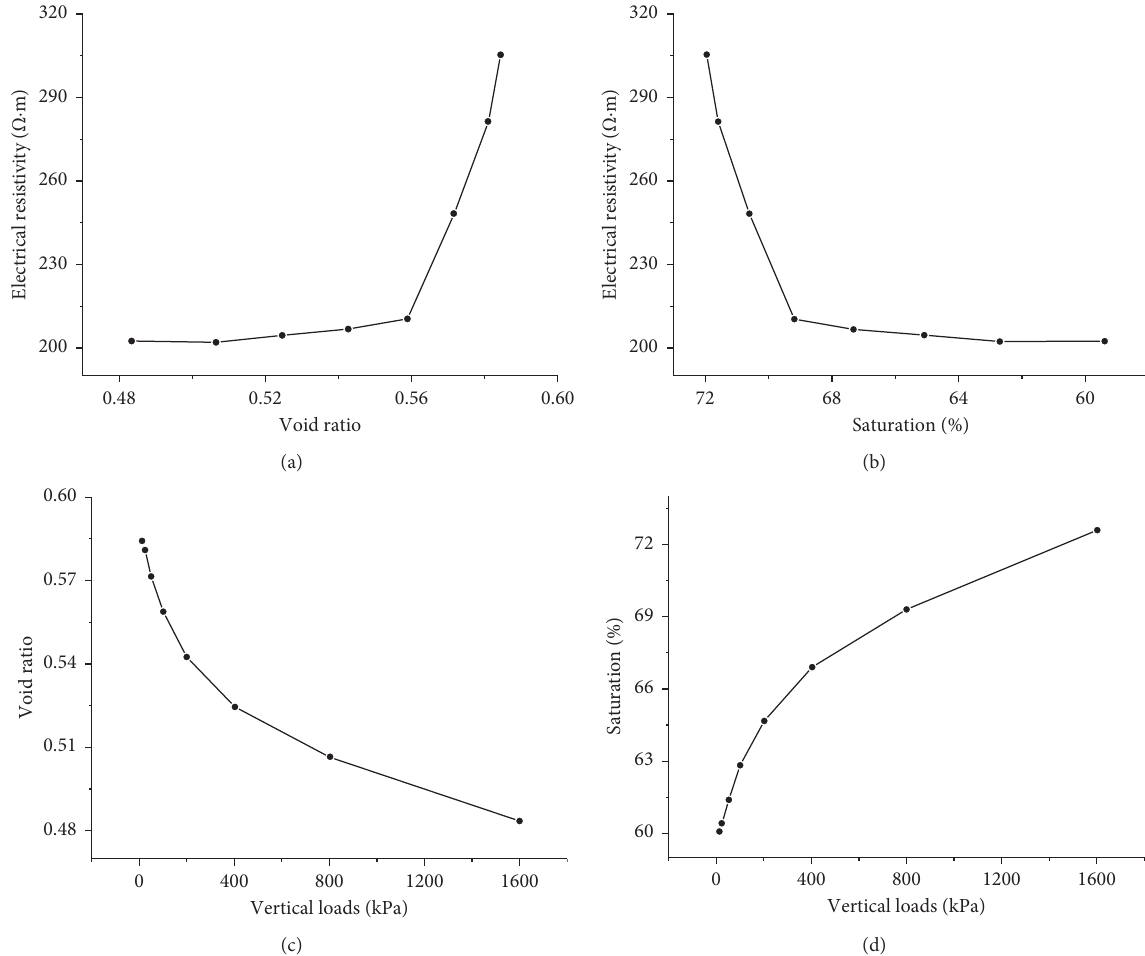
Figure 6: Relationship curve between void ratio, degree of saturation, resistivity, and vertical pressure stress of loess.